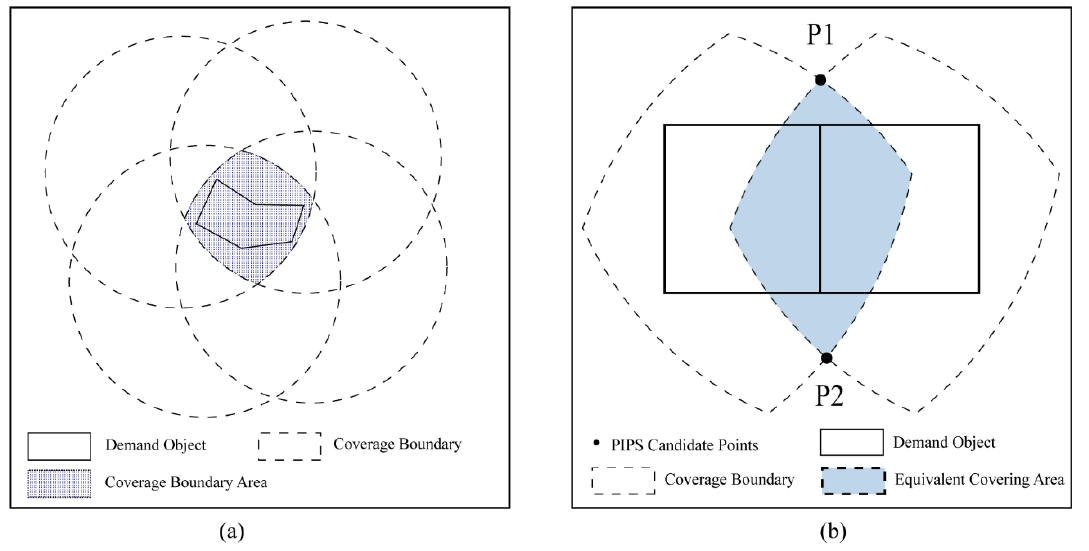
Figure 2. Setting the candidate points. ( a ) Determination of the covering boundary for the polygon requirement object. ( b ) Candidate selection by polygon intersection point set (PIPS).